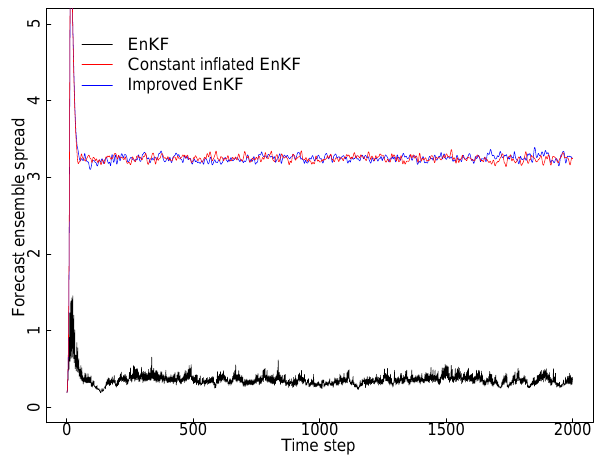
Figure 4. GAI statistics of the conventional EnKF (black line), the constant inflated EnKF (red line) and the improved EnKF (blue line) for the Lorenz-96 experiment with 40-observation and 30-ensemble member. The constant multiplicative inflation factor is set as